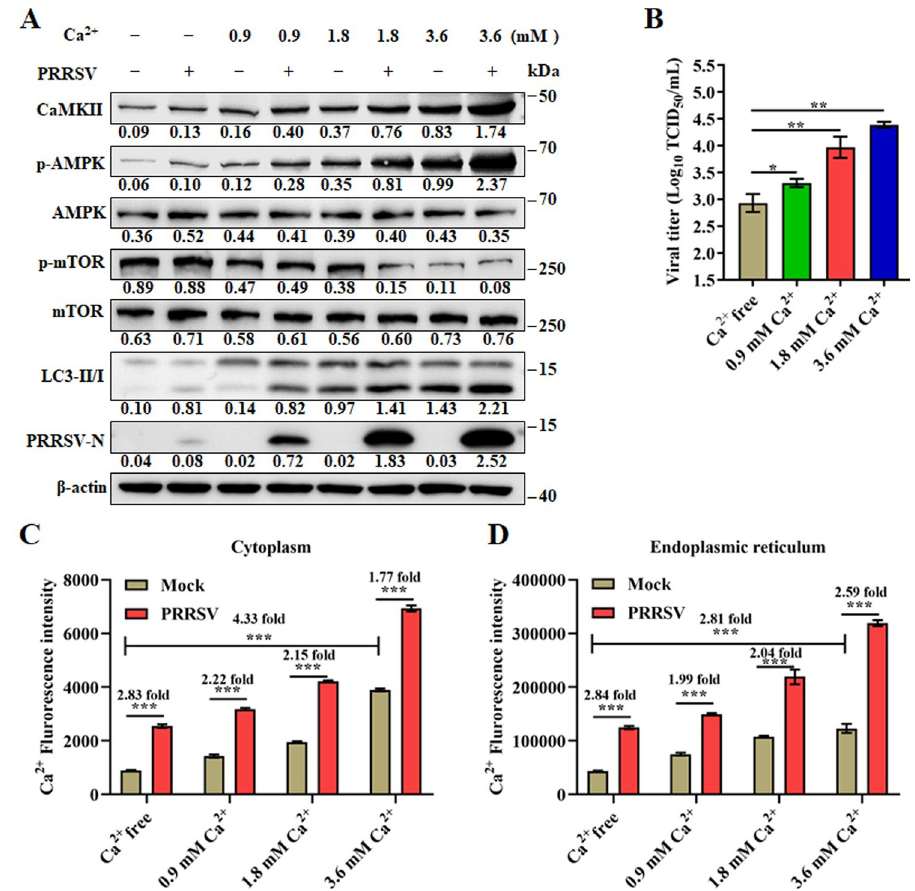
Fig 5. The ER takes up extracellular calcium during PRRSV infection. (A-C) Marc-145 cells were infected with PRRSV (MOI = 0.1) and cultured in media containing 0, 0.9, 1.8, or 3.6 mM calcium chloride for 24 h. ( A ) Cell lysates were analyzed by western blotting for CaMKII, p-AMPK, AMPK, p-mTOR, mTOR, LC3-I/II, PRRSV-N, and β -actin. ( B ) TCID 50 of PRRSV in cell supernatants. ( C ) Cytoplasmic Ca 2+ levels were determined by fluorescence of Fluo-8. ( D ) ER associated Ca 2+ levels were determined by a Fluo-8 calcium flux analysis kit as described in Material and Methods. The protein levels were quantified by Image J and normalized to β -actin. The data are representative of results from three independent experiments. Error bars indicate the mean ( ± SD) of three independent experiments. * , p < 0.05; ** , p < 0.01; and *** , p <